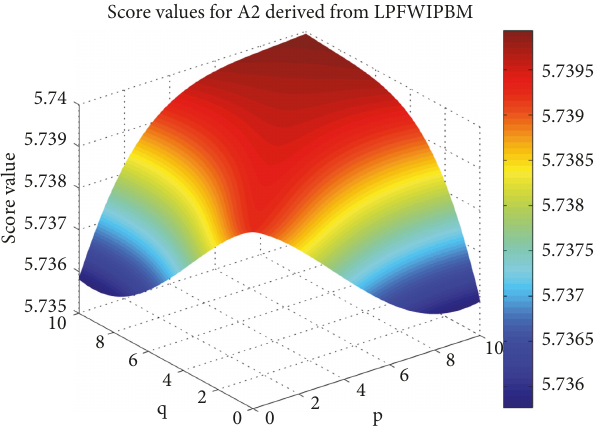
Figure 2: Score values of alternative A1 derived from LPFWIPBM when 𝑝, 𝑞 ∈ (0, 10) . Score values for A2 derived from LPFWIPBM